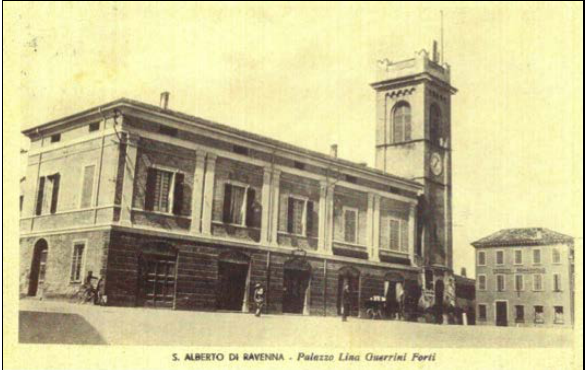
Figure 2. The civic tower in its original position in Garibaldi square (postcard from private